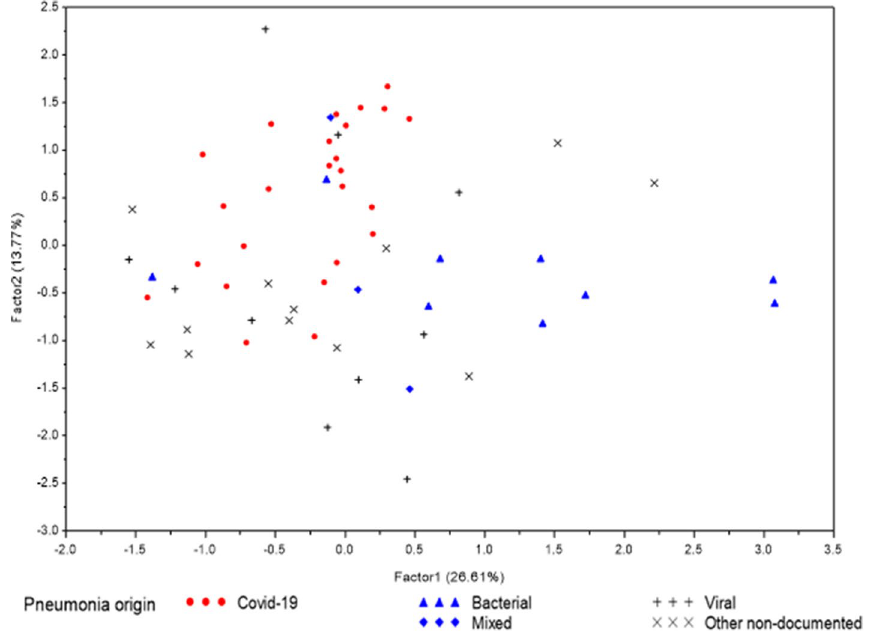
Figure 2. Factorial map for the primary component analysis. Patients are located according to their representation on each axis. Factor 1 appears to separate bacterial and viral pneumonia whereas factor 2 appears to separate COVID-19 and non-COVID pneumonia.